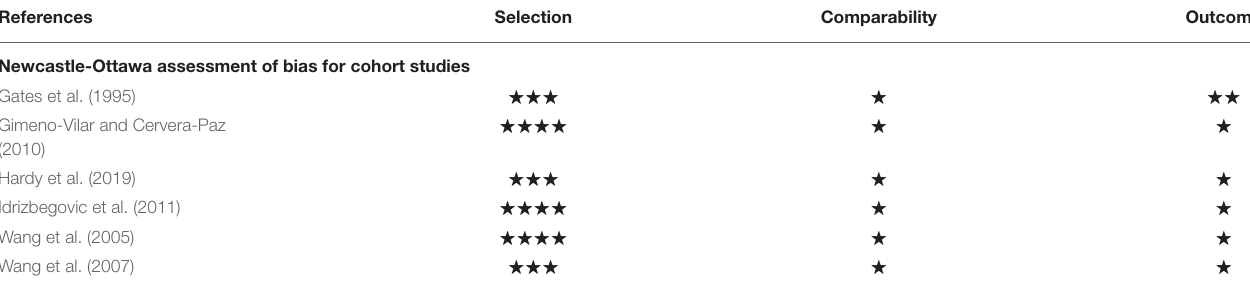
TABLE 1 | Risk of bias scores calculated for included studies using the Newcastle Ottawa Scale for Cohort